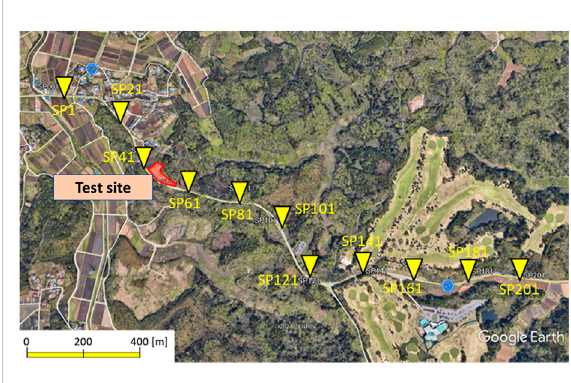
FIGURE 4 Overview of a test fi eld for DAS fi eld measurement in Chiba, Japan.